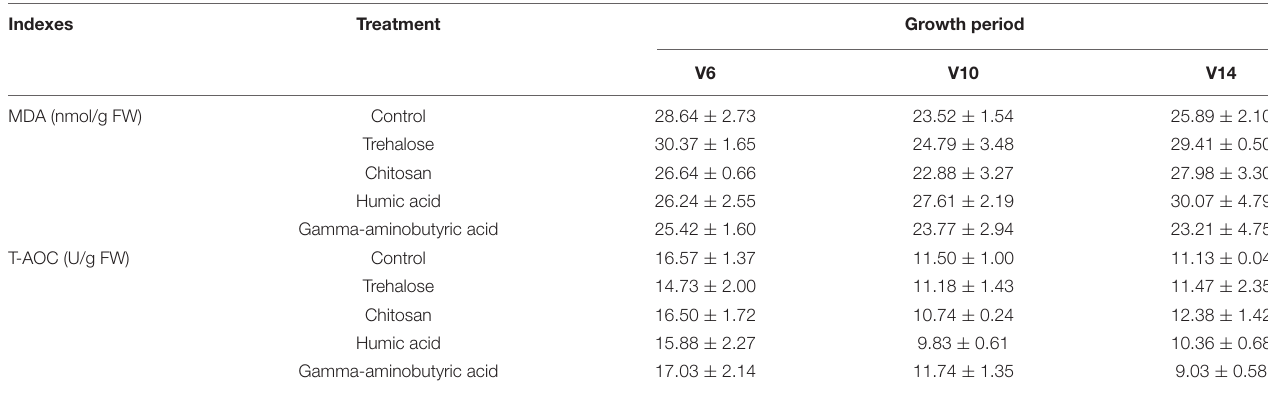
Statistical analysis was used to compare differences in means between PGR treatments shown. Within each stage, treatments labeled with different lowercase letters were significantly different (P < 0.05; n = 3), and the lack of such letters indicates the lack of a significant difference. V6, V10, and V14 represent the 6-, 10-, and 14-leaf stages of vegetative growth, respectively. MDA, malondialdehyde; T-AOC, total antioxidant capacity; FW, fresh weight.